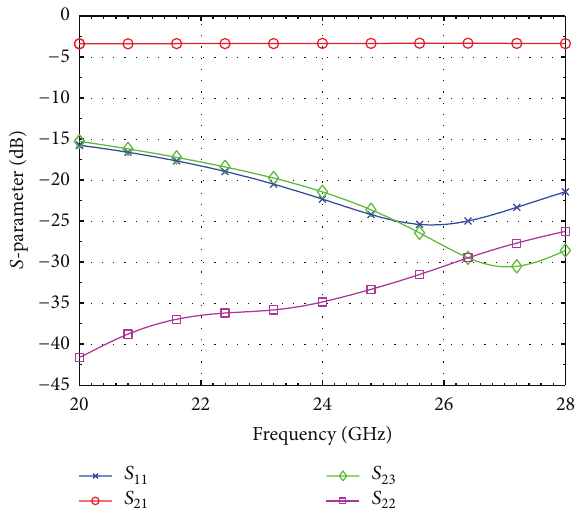
Figure 8: Simulated scattering parameters of power divider.